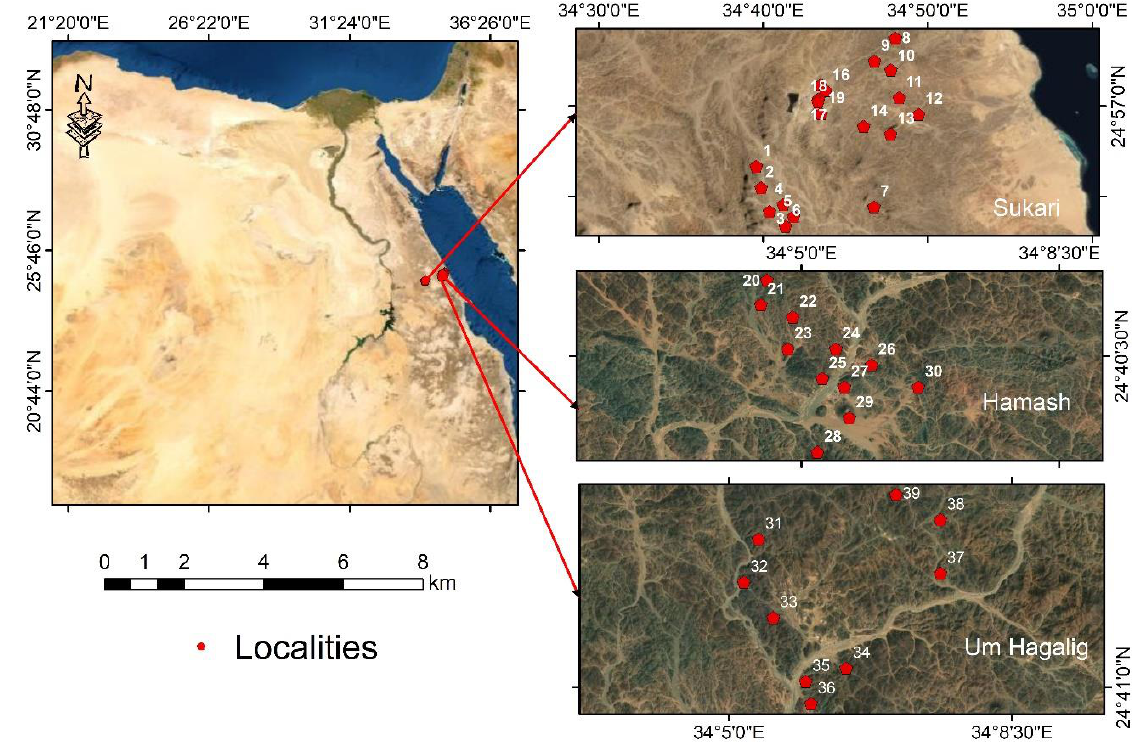
Figure 1. The map of localities of the studied areas.